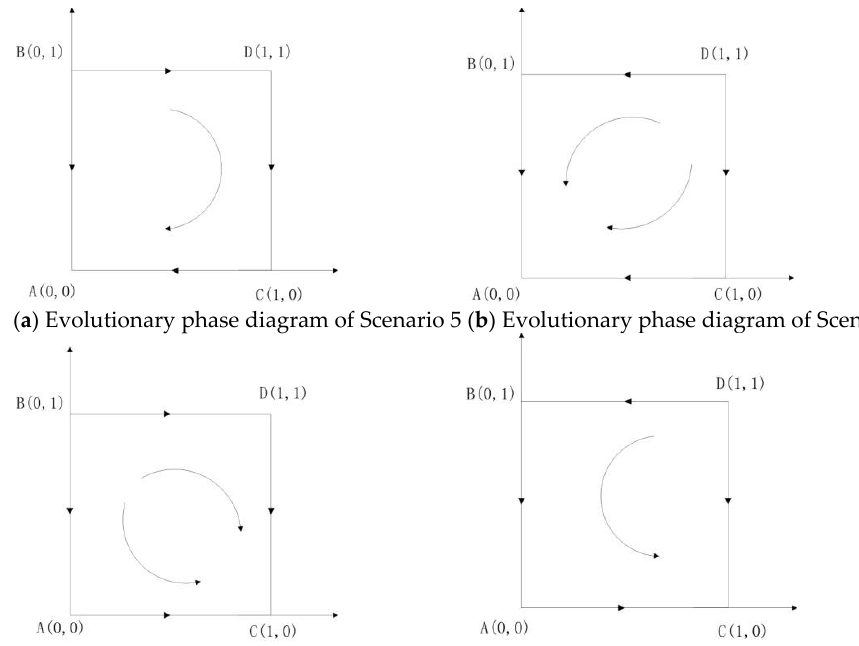
Figure A1. Evolutionary phase diagrams of Scenario 5 to 8.